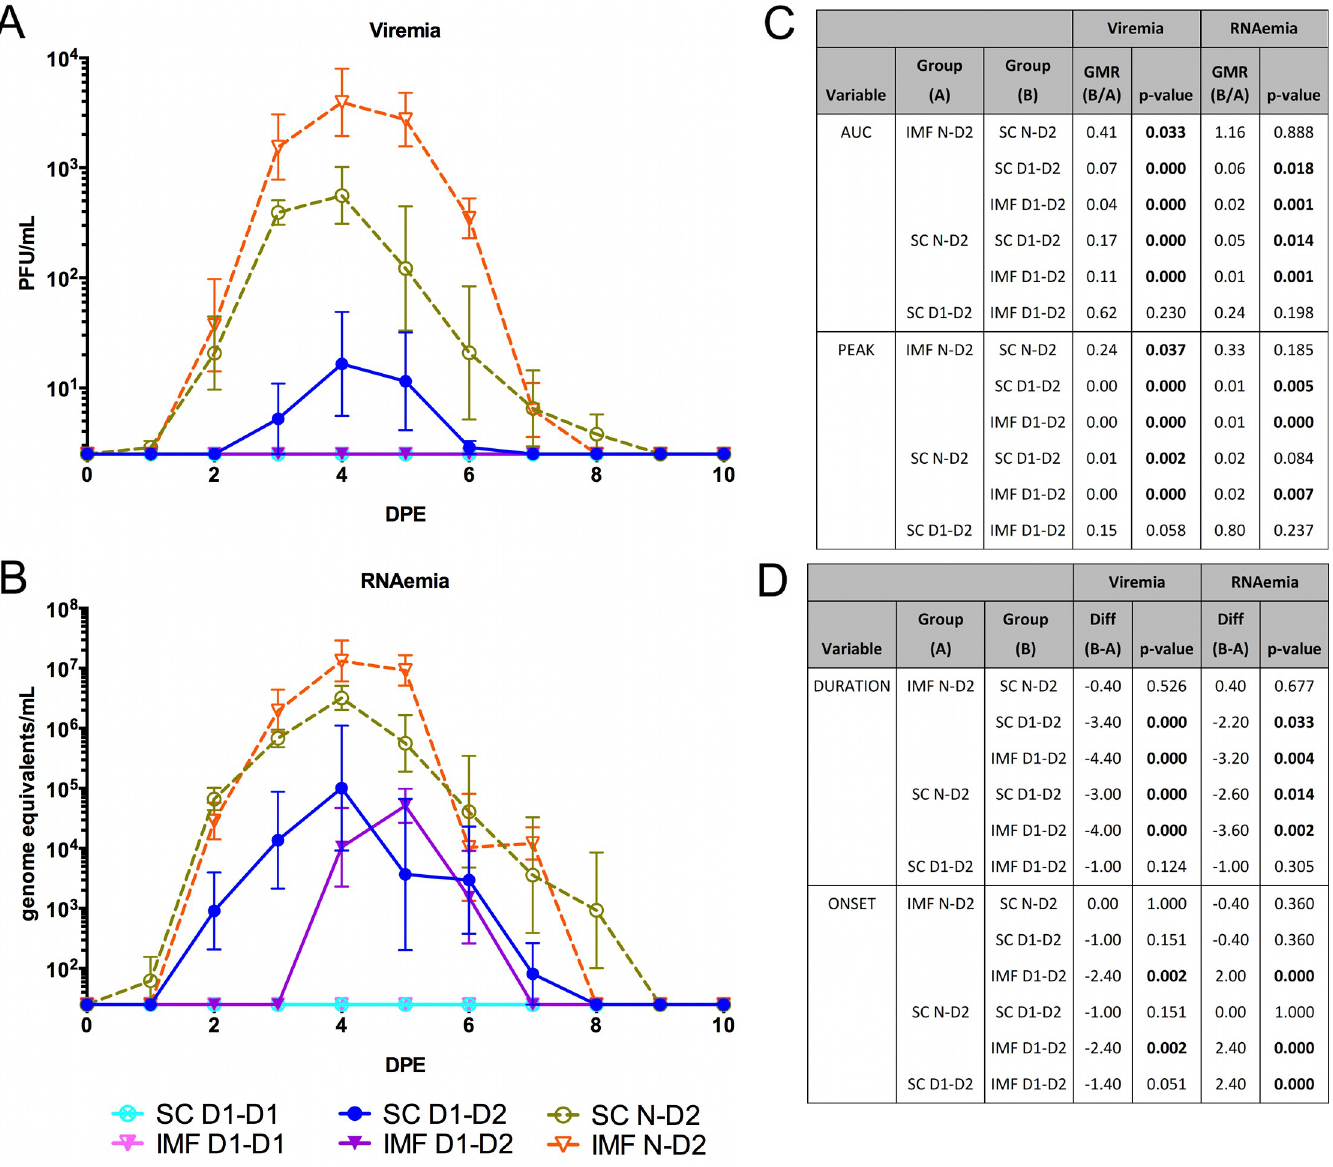
Fig 6. Comparative viremia and RNAemia profiles associated with homologous versus heterologous secondary DENV infection. At month 15 post primary DENV- 1 infection, the SC and IMF groups were divided into two subgroups, each of which were exposed to either DENV-1 or DENV-2 using the same administration route that was used for their respective primary infections. In parallel, DENV-na ï ve macaques were exposed to DENV-2, either via SC inoculation or IMF, as controls for primary DENV-2 infection. Sera were collected daily following DENV exposure and tested, in duplicate, by A) plaque assay for their infectious virus (viremia) titer expressed as PFU/mL, and by B) qRT-PCR for their RNAemia titer expressed as genome equivalents/mL. Geometric mean titers with standard error of the log 10 - transformed mean are displayed (n = 5/subgroup). C) Geometric mean ratios (GMR) and p-values for between group comparisons of viremia and RNAemia areas under the curve (AUC) and peak titers are shown. AUC and peak titers were log 10 -transformed for statistical analysis using an ANOVA model. Peak titers were additionally compared using a non-parametric analysis (ANOVA on ranks) to confirm the log 10 -transformed results. D) Viremia and RNAemia times to onset and durations were compared between groups using an ANOVA model, with LS means differences and p-values shown. SC, subcutaneous; IMF, infectious mosquito feeding; D1-D1, homologous DENV-1; D1-D2, heterologous DENV-2; N-D2, primary